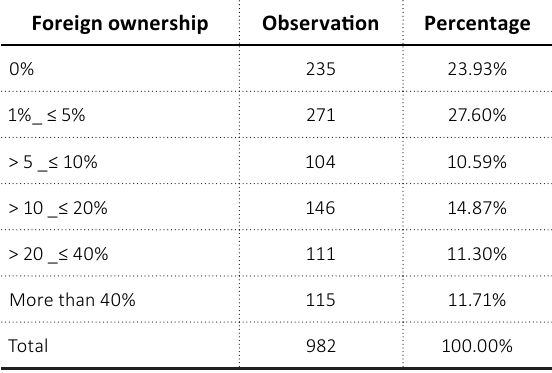
Table 2. Frequencies of firms of the study according to foreign ownership percentage